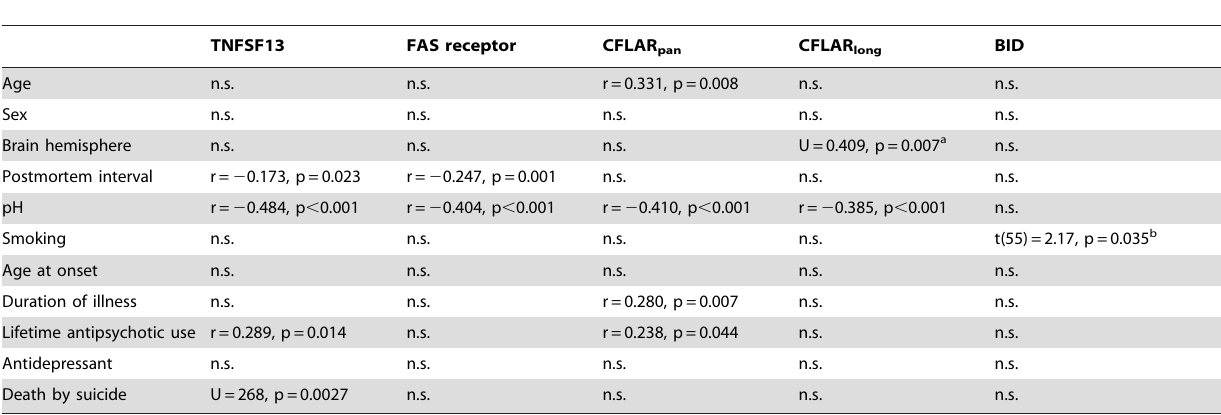
Table 3. Relationship of gene expression in the DLPFC with demographic and clinical variables.